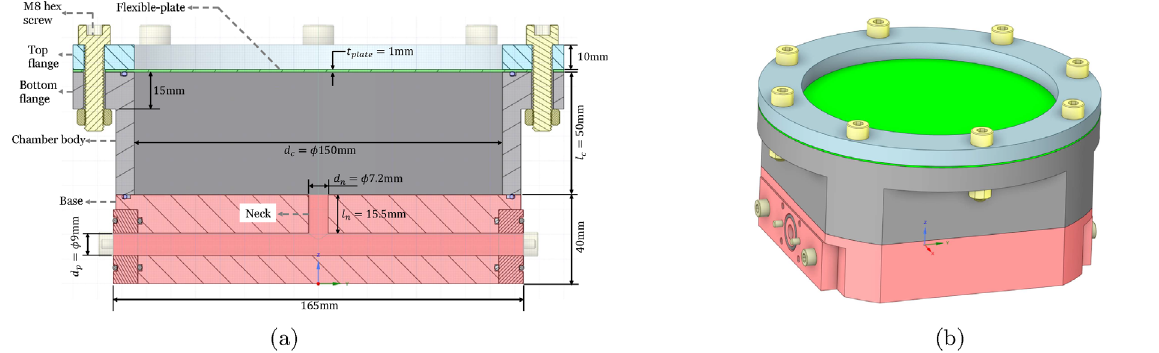
Figure 2. Diagram and dimensions of the fl exible-plate resonator. (a) Internal dimensions of fl exible-plate resonator. (b) A parallel- perspective view of the